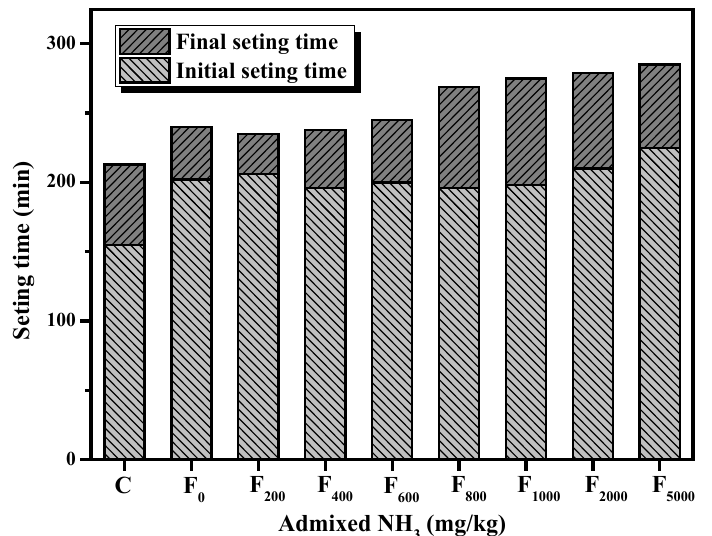
Figure 9. Changes in the setting time of the cement paste with increasing ammonia content in fly ash.